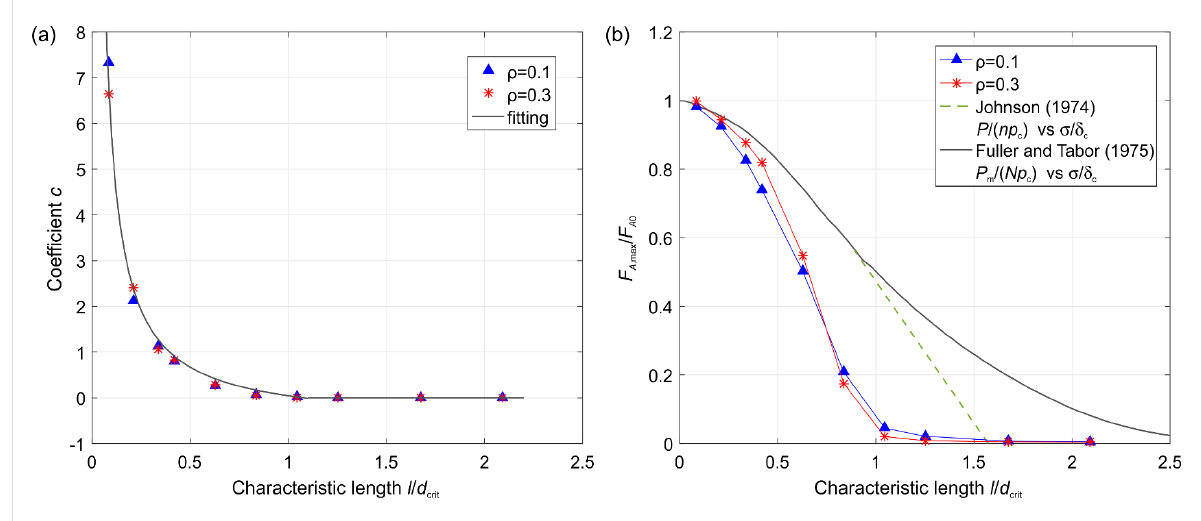
Figure 5: (a) Dependence of the coefficient C on the characteristic length in region I (Figure 4); (b) the maximum value of the adhesive force at the plateau (region III, Figure 4).